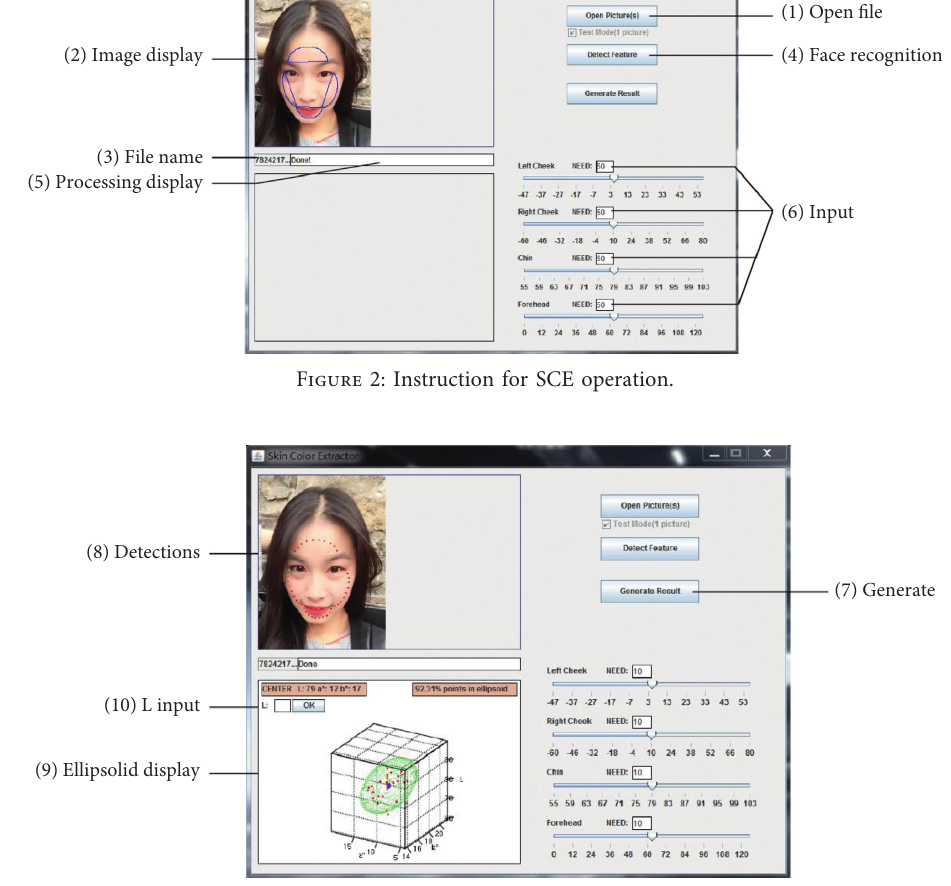
Figure 3: Processing by single image.